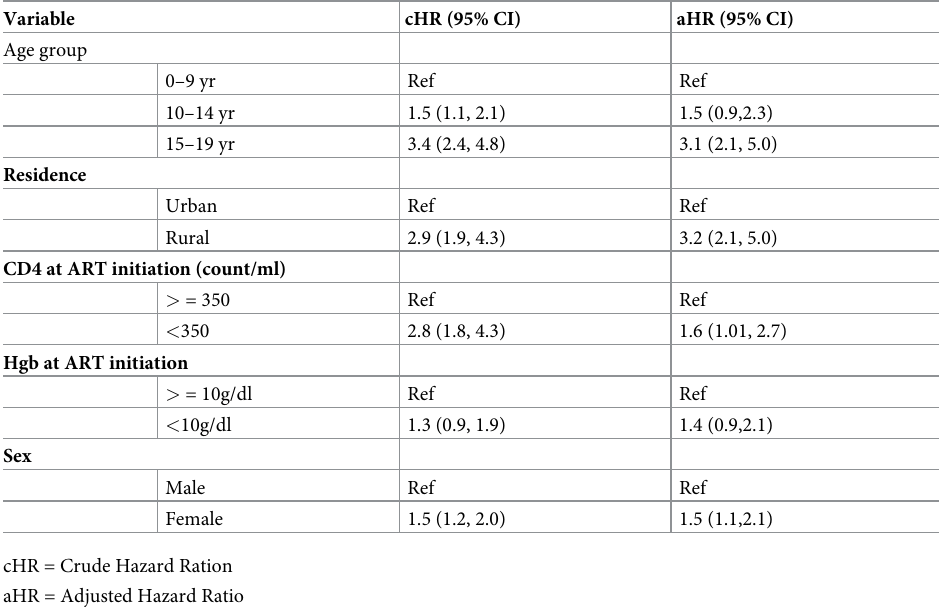
Table 3. Predictors of LTFU after ART initiation among adolescents and children (n =